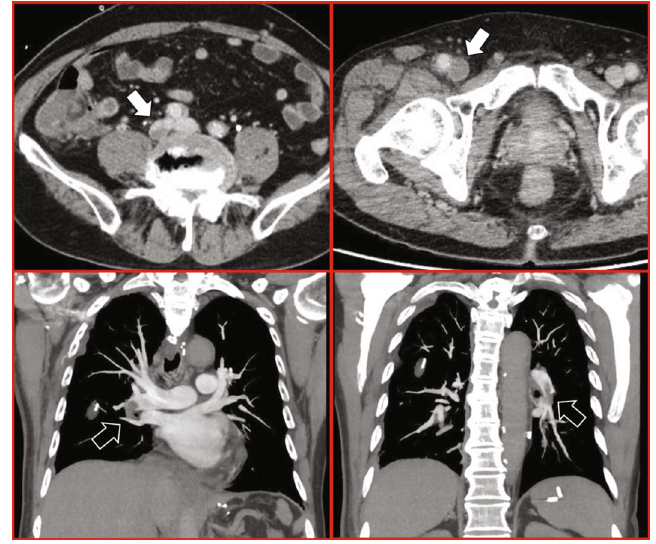
Figure 1: Contrast computed tomography imaging. White arrows indicate the region from the right iliac to the common femoral vein that was occluded by deep vein thrombosis, whereas black arrows indicate the bilateral pulmonary artery thromboembolism.